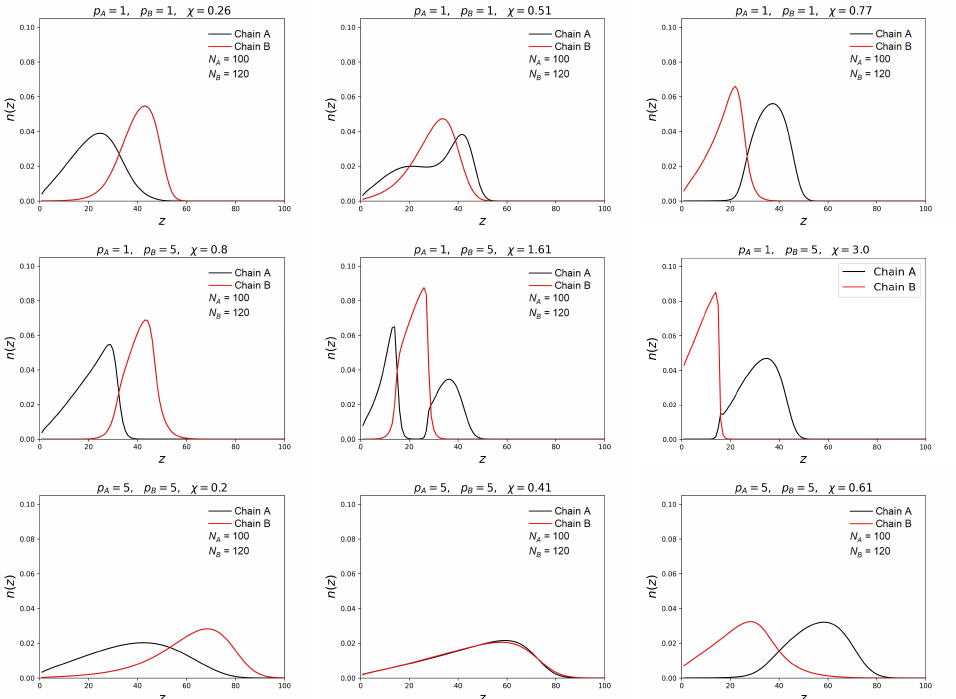
Figure 3. Distribution profiles of the chain free ends in the binary brushes. The notations are the same as in the previous